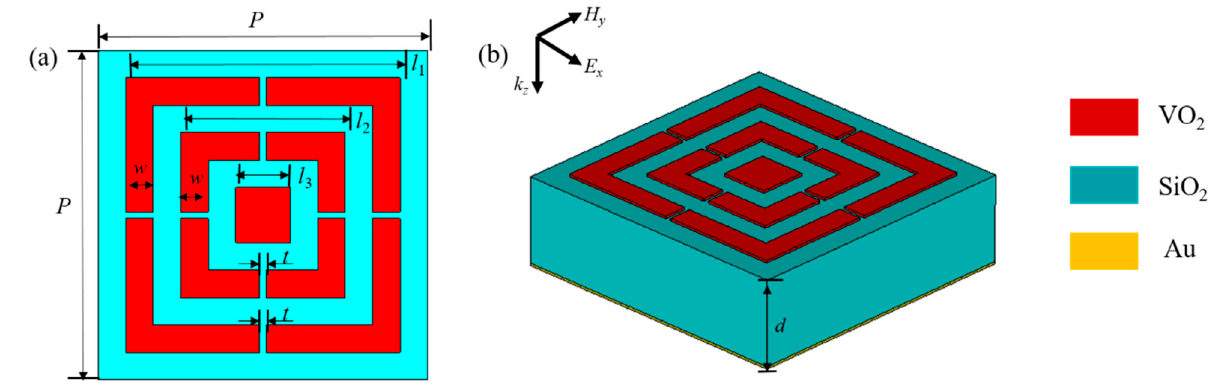
Figure 1. Unit cell of the structure in ( a ) top view and ( b ) three-dimensional schematic. The conductivity σ 0 in Formula (2) is 3 × 10 5 S/m and ω p ( σ 0 ) is 1.4 × 10 15 rad/s. We